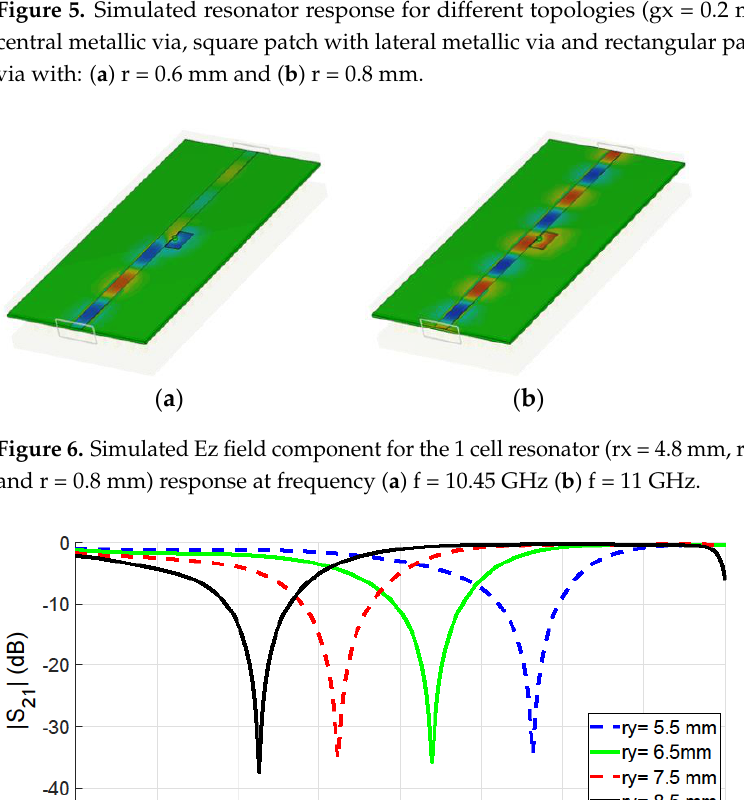
Figure 5. Simulated resonator response for different topologies (gx = 0.2 mm); square patch with central metallic via, square patch with lateral metallic via and rectangular patch with lateral metallic via with: ( a ) r = 0.6 mm and ( b ) r = 0.8 mm.